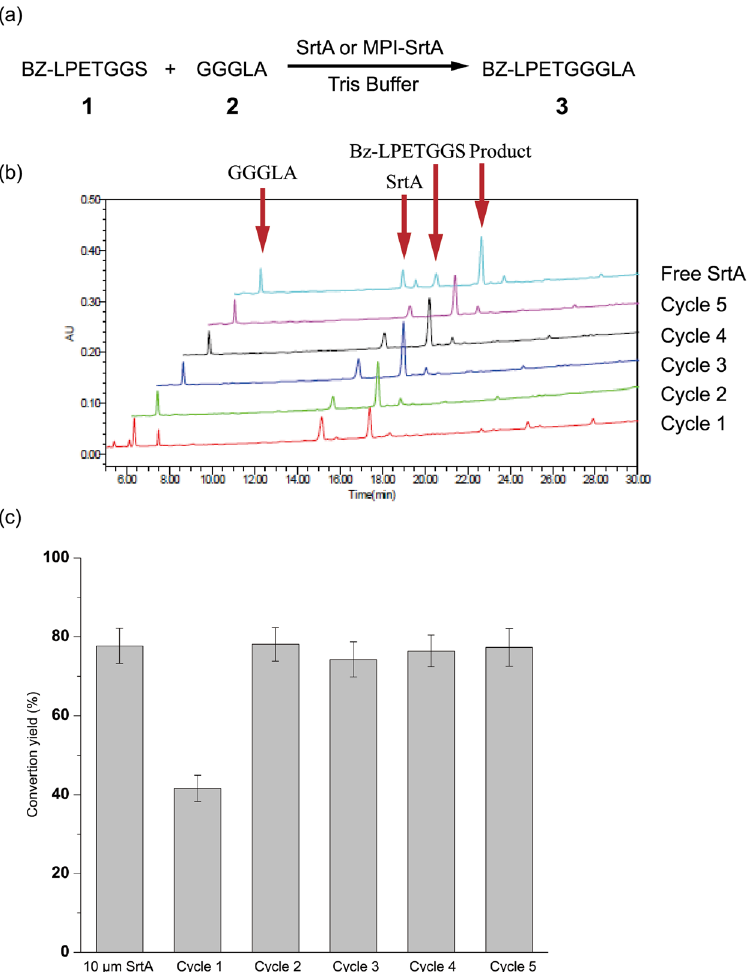
Figure 3. MPI-SrtA- or free SrtA-catalyzed peptide-to-peptide ligation. ( a ) Ligation reaction of peptide Bz- LPETGGS 1 and GGGGLA 2 , conditions: 0.3 M Tris-HCl buffer (pH = 7.5) containing 0.15 M NaCl, 5 mM CaCl 2 , 2 mM 2-mercaptoethanol, 0.125 mM peptide 1 and 0.625 mM peptide 2 in the presence of 100 μ L MPI- SrtA or 10 μ M free SrtA. ( b ) HPLC diagraph of MPI-SrtA- or free SrtA-catalyzed peptide-to-peptide ligation. ( c ) Reuse and recycling of MPI-SrtA in peptide-to-peptide